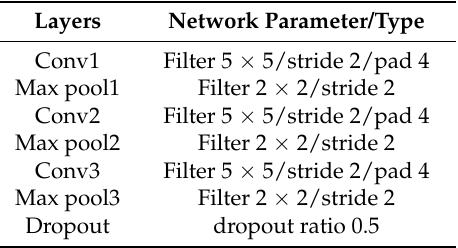
Table 1. Parameters of the CNN